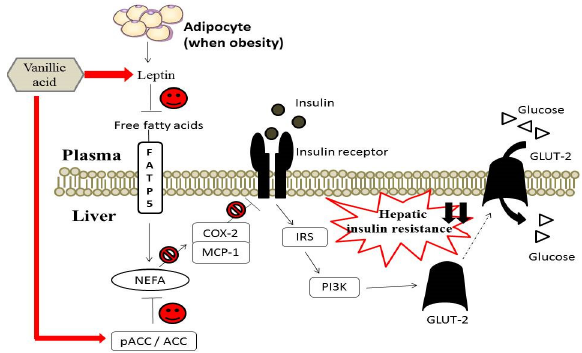
Figure 5. The postulated mechanisms underlying the effect of vanillic acid on hepatic insulin resistance by regulating insulin signaling and inflammation pathways in rats fed an HFD.